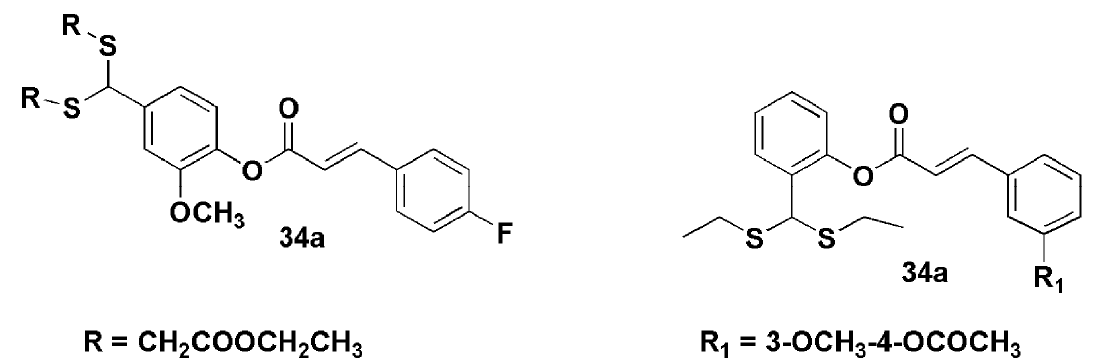
Figure 7. Cinnamic acid derivatives with dithioacetal moieties ( 34a and 34b ) [27].